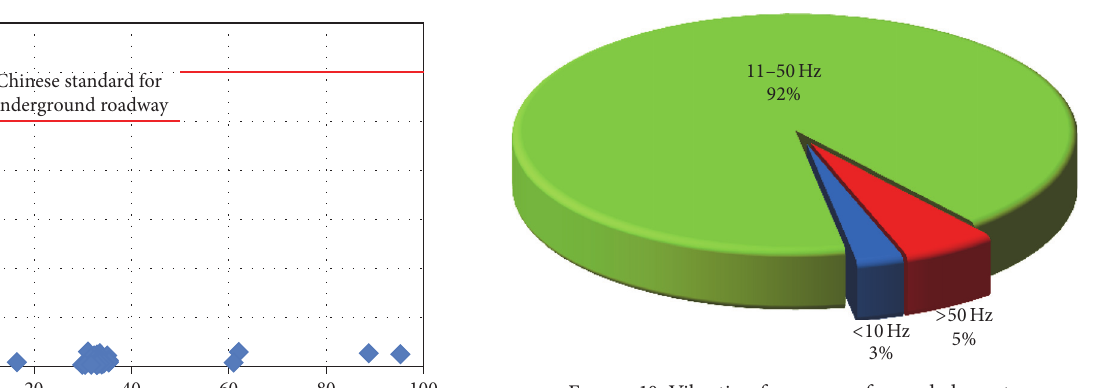
Figure 10: Vibration frequency of recorded